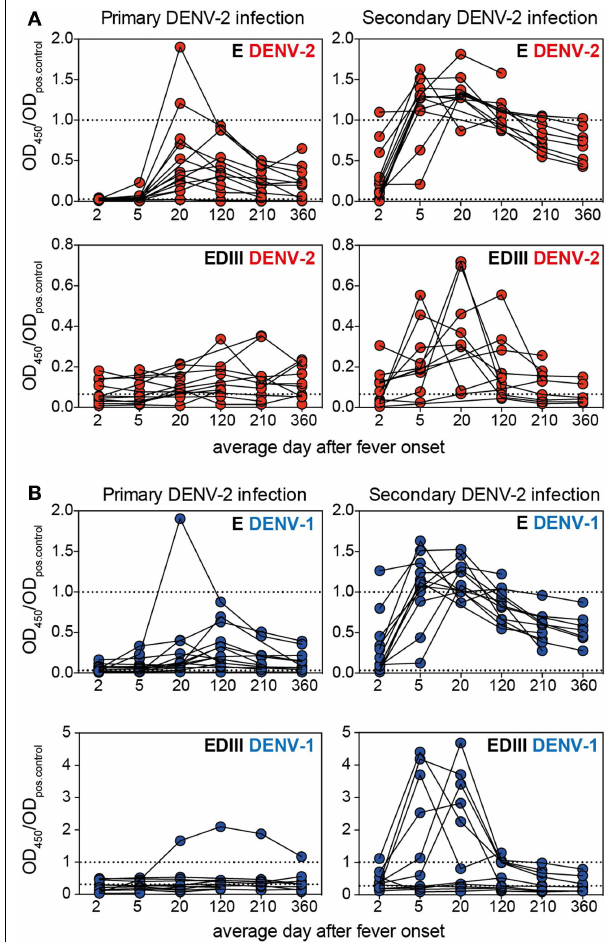
FIGURE 3 |The EDIII-specific antibody titers vary substantially between patients and are not long-lasting . Plasma samples from patients with primary or secondary infection were analyzed for binding to E and EDIII protein and each patient’s antibody binding profile is shown individually by connected symbols.The mean values for the same data are shown in Figures 1B,C . (A) Individual curves for binding to DENV-2 E and EDIII protein. (B) Individual curves for binding to DENV-1 E and EDIII protein.The dashed lines indicate values for pooled neg. and positive control plasma, respectively. Mouse mAb 3H5 was used as a positive control for the DENV-2 EDIII ELISA because the pooled positive plasma did not show more binding to DENV-2 EDIII than the pooled negative plasma. The use of a different positive controls for DENV-1 and DENV-2 resulted in OD ratios of a different scale for the two EDIII